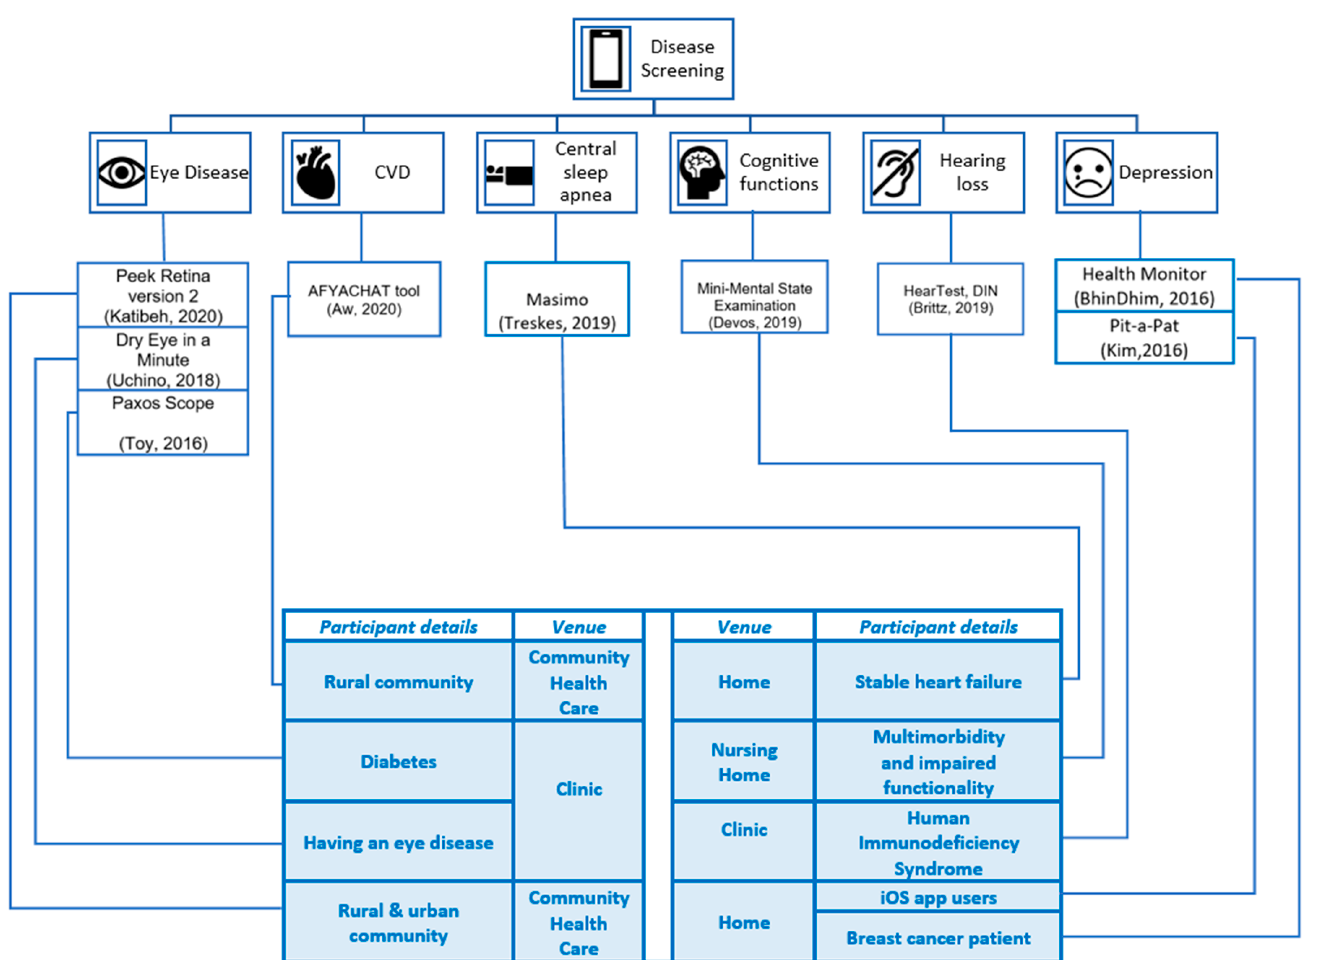
Figure 2. Disease-screening apps screen eye disease, cardiovascular disease, central sleep apnoea, cognitive functions, hearing loss, and depression.